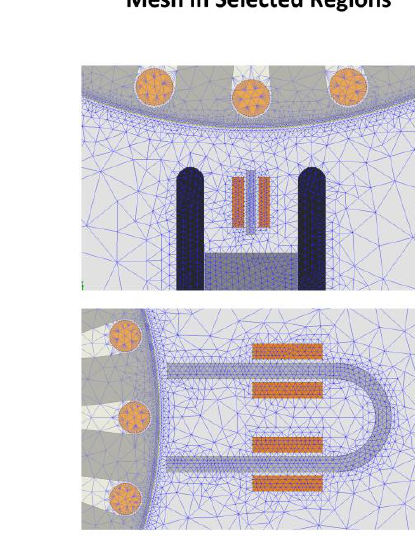
right along the direction of rotor rotation. In the air gap and rotor bar regions, the model